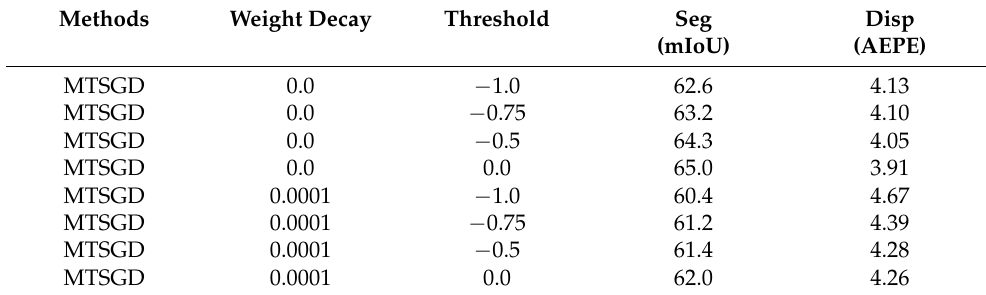
Table 3. Investigation of weight decay for MTSGD. ’Weight Decay’ denotes the L2 regularization term of weight decay, and 0 indicates that there is no regularization term during training. Methods Weight